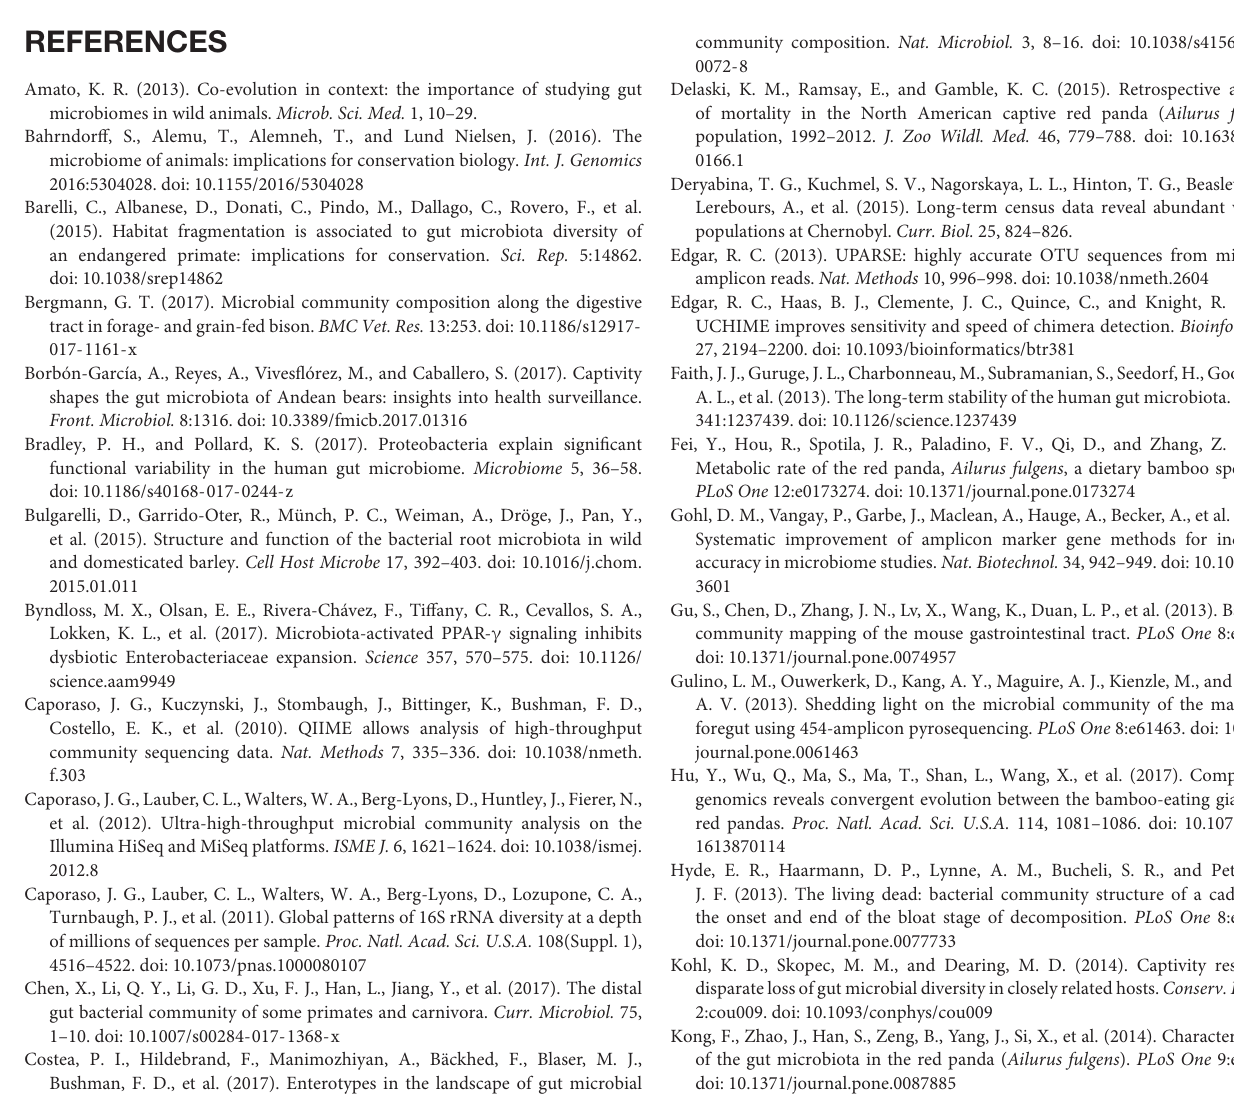
FIGURE S1 | Tag information and bacterial classification. (A) Total tags, taxon tags, operational taxonomic units (OTUs), unclassified tags, and unique tags. (B) The classification level includes the kingdom, phylum, class, order, family, genus, and species. FIGURE S2 | Rarefaction curve analysis. Duplicate samples of OTU subgroups are evaluated whether further sampling would likely yield additional taxa, as indicated by the plateau value. (A) The y-axis represents the number of OTUs detected and the x-axis indicates the number of taxa in the analyzed subsets of sequences. (B) Rank abundance curves were used to estimate the richness and evenness of taxa present in the samples. The y-axis indicates the relative abundance of OTUs and the x-axis indicates the number of OTUs according to the relative abundance from largest to smallest. The larger the span curve is on the x-axis, the higher the species richness. The smoother the curve on the y-axis, the more evenly the species are distributed. FIGURE S3 | Species-specific tree analysis of bacteria from the (A) stomach, (B) duodenum, (C) jejunum, (D) ileum, (E) colon, (F) rectum, and (G) faecal. The first percentile in brackets shows the percentage of all detected bacteria in the microbiota. The second percentile in parentheses shows the percentage of microbial communities in all selected bacteria. FIGURE S4 | Top 100 bacteria genus in the evolutionary tree of red panda GIT.